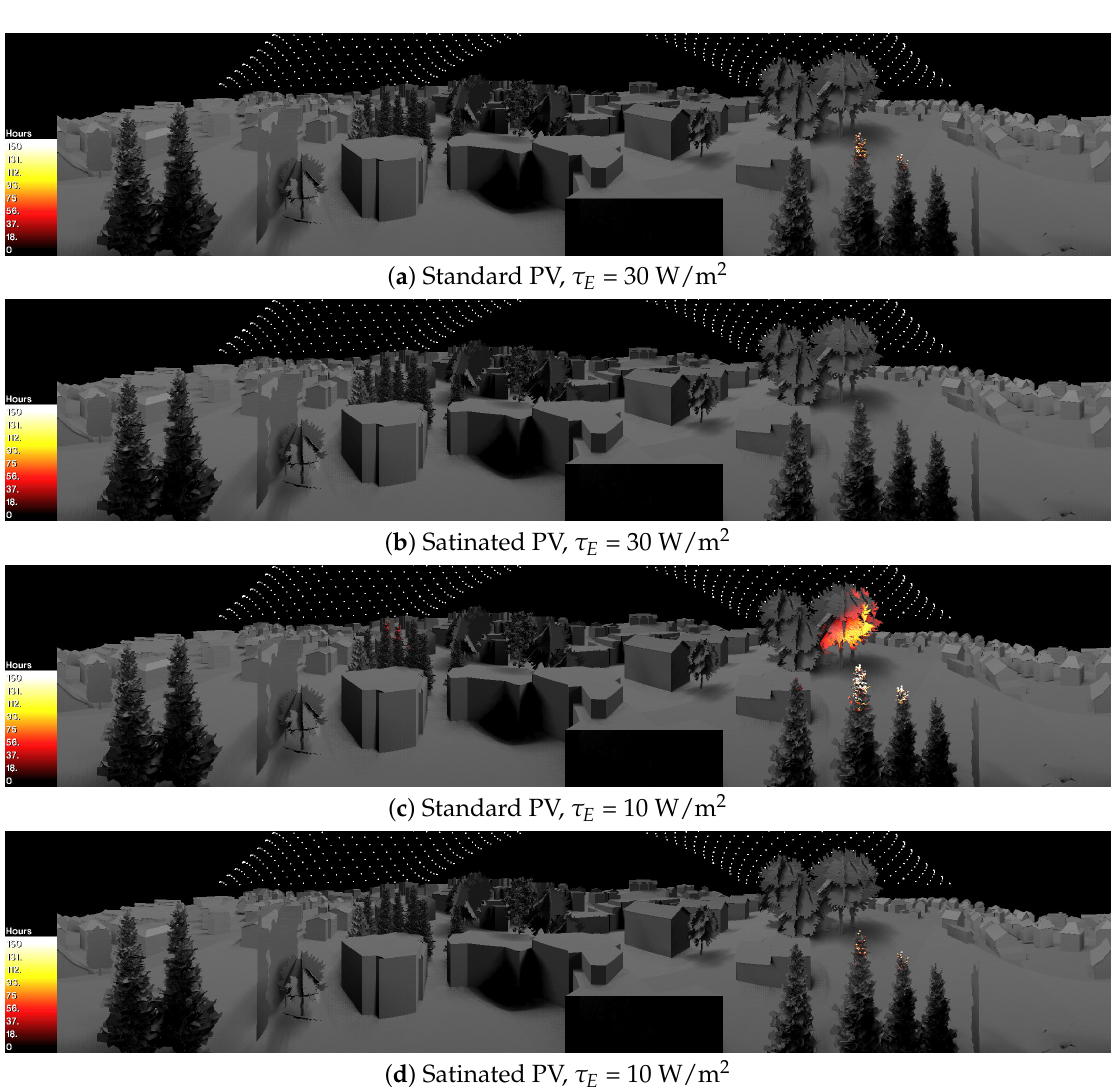
Figure 14. Panoramic views of cumulative annual glare duration in hours for standard ( a , c ) and satinated ( b , d ) PV modules. Glare is identified according to irradiance thresholds τ E = 30 W/m 2 as recommended by Swissolar ( a , b ), and τ E = 10 W/m 2 as suggested by Sandia Labs ( c , d